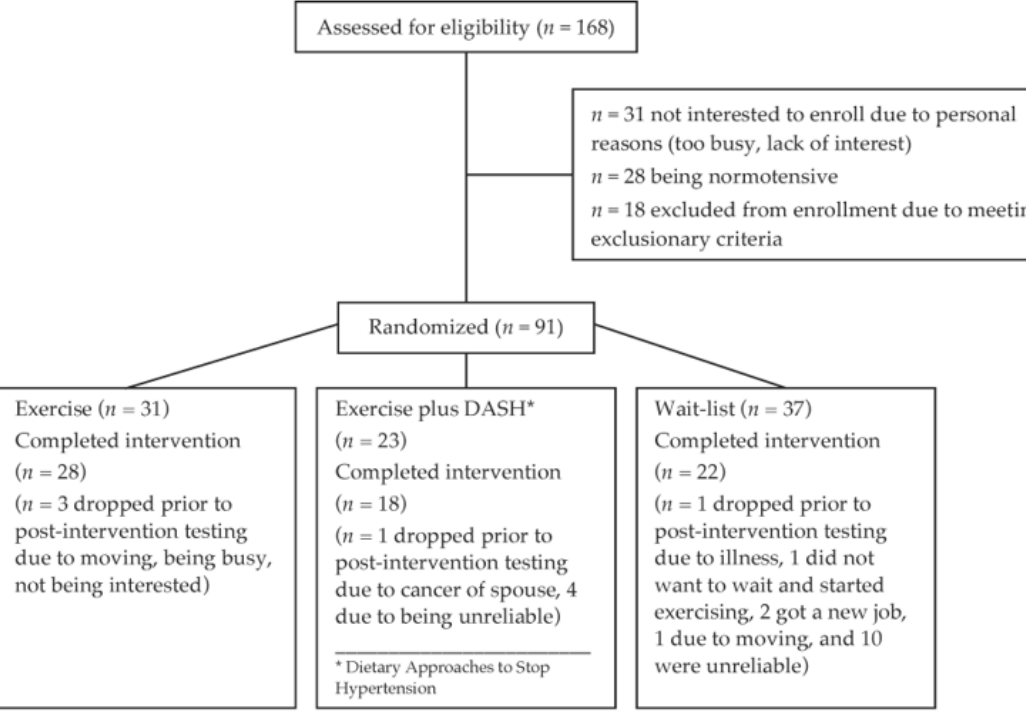
Figure 1. CONSORT flow diagram for participants.